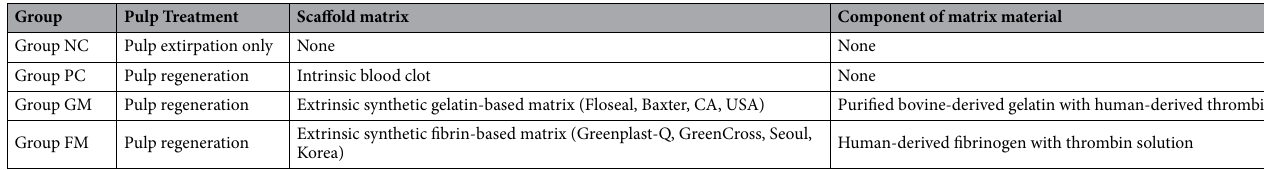
Table 1. Experimental groups of the in vivo study. NC negative control, PC positive control, GM gelatin-based matrix, FM fibrin-based